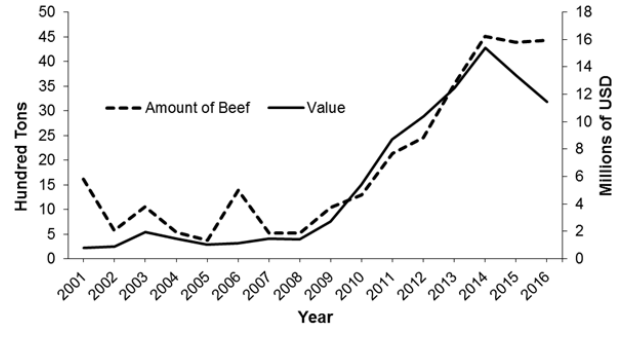
Fig. 2 . The quantity and economic value of South African beef exported to Mozambique from 2001 to 2016 (International Trade Centre